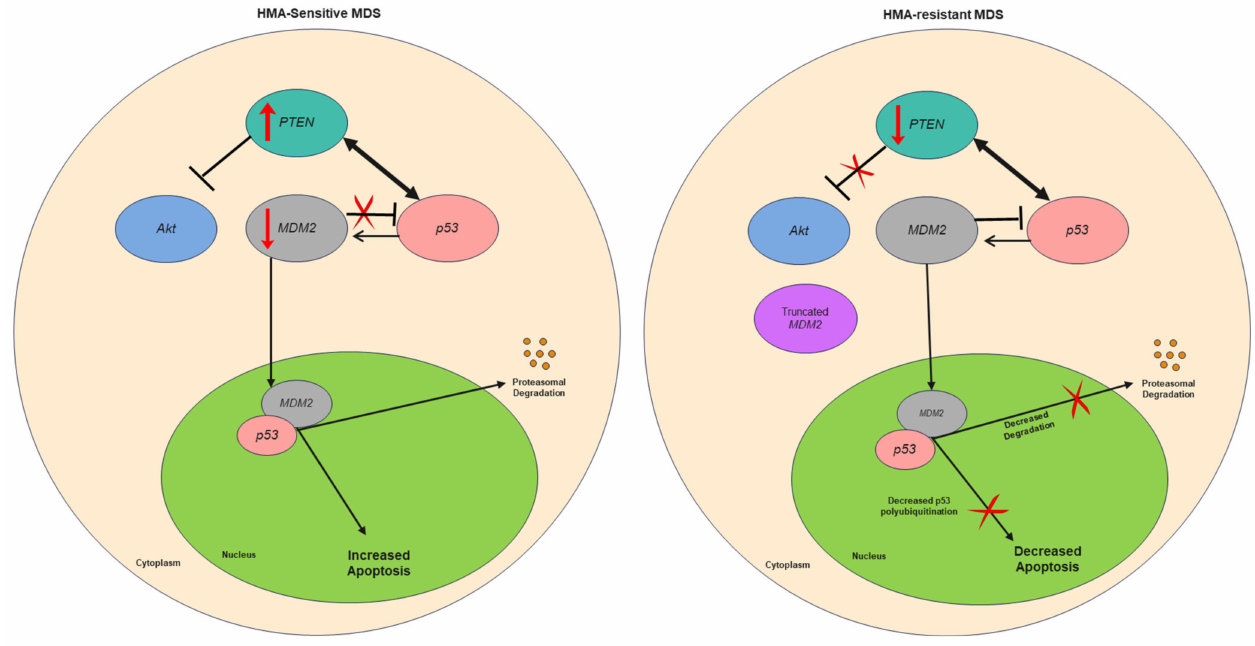
Figure 5. Proposed molecular mechanism of resistance to hypomethylating agents involving PTEN and MDM2. During resistance to hypomethylating agents, further suppression of PTEN is associated with CpG DNA hypermethylation. RNA M6A hypomethylation led to unexpected alternative splicing, which resulted in up-regulation of truncated MDM2 mRNA as non-coding transcript with only the 3 (cid:48) untranslated region. PTEN functions as a tumor suppressor gene and inhibits PI3K/Akt signaling. This inhibition is lost upon DNA hypermethylation of PTEN during HMA-resistance. On the other hand, a shift in the function of MDM2 could be associated with HMA-resistance, with MDM2 initially being an oncoprotein conventionally known to negatively regulate p53. During HMA resistance, MDM2 is switched into a p53 enhancer, but the expression of MDM2 was suppressed due to RNA hypomethylation and altered MDM2 splicing. Therefore, PTEN and MDM2 silencing collectively result in dysregulated